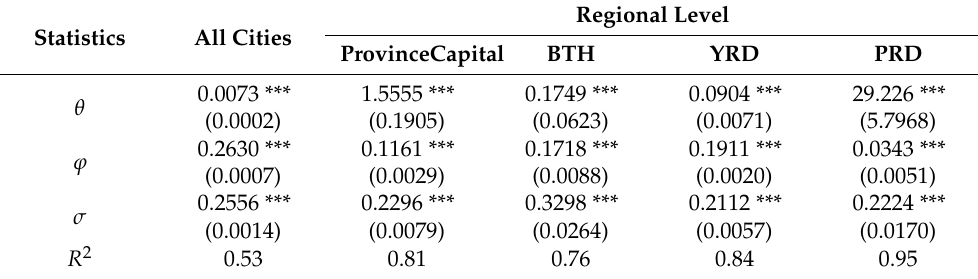
Table 2. The gravity model